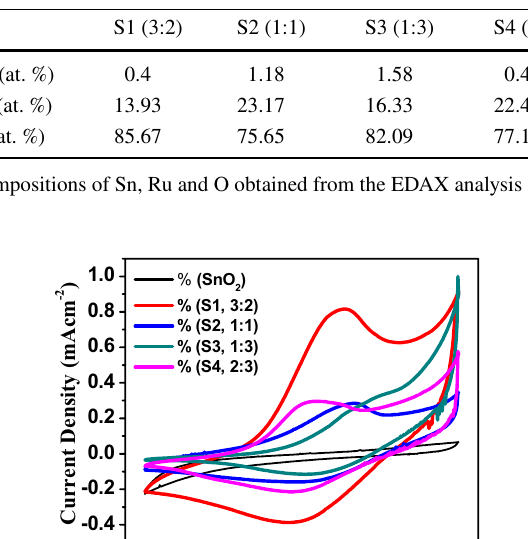
Table 2 SnO 2 :RuO 2 cycle ratio in SILAR deposition